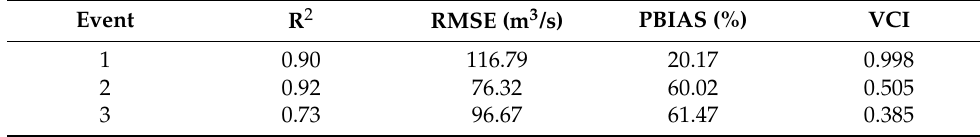
Table 5. Statistical analysis of observed and simulated values of flow